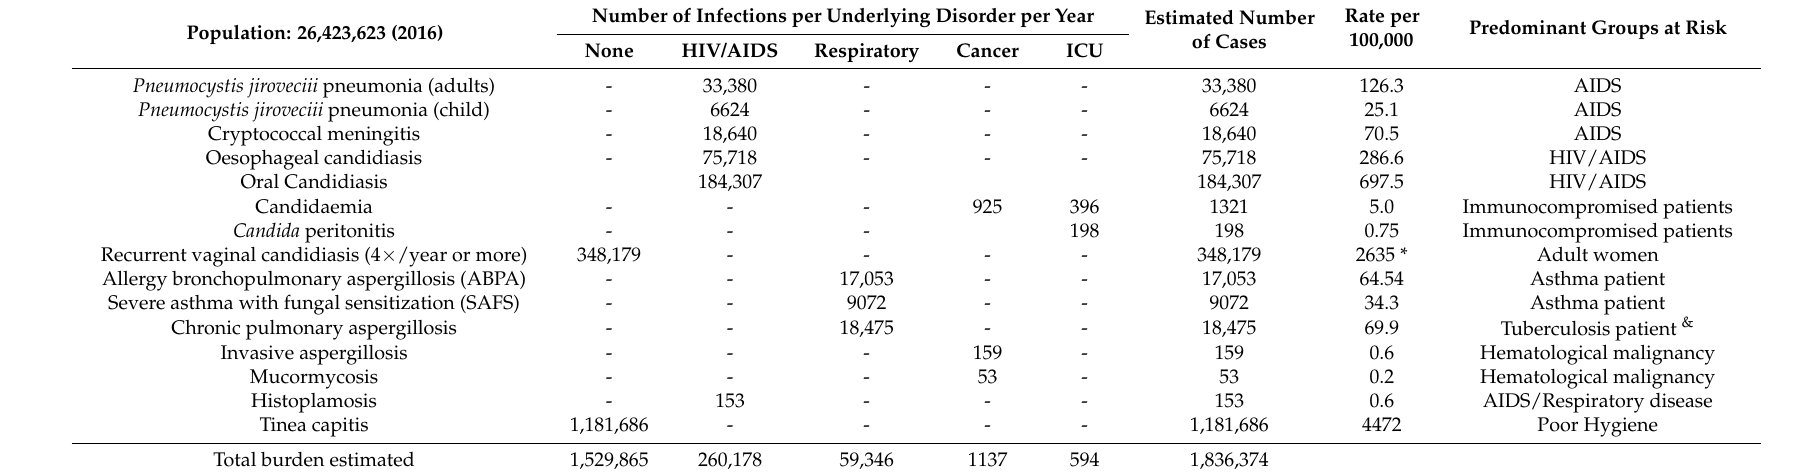
Table 3. Burden of fungal diseases in Mozambique according the main risk factors